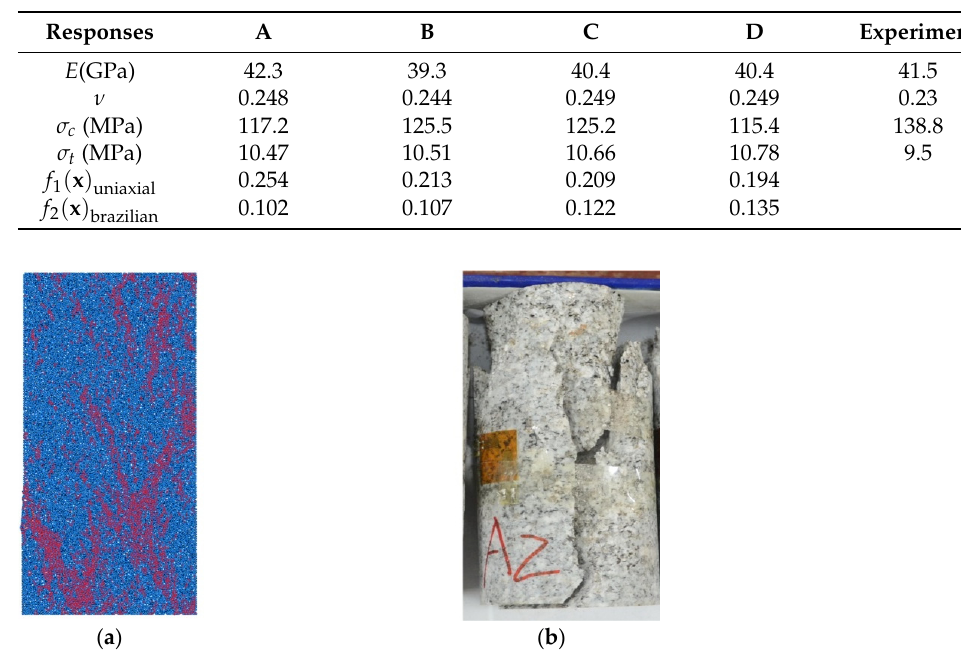
Figure 12. The material fractures under uniaxial compressive test. ( a ) DEM calculation with individual B; ( b ) Experiment.